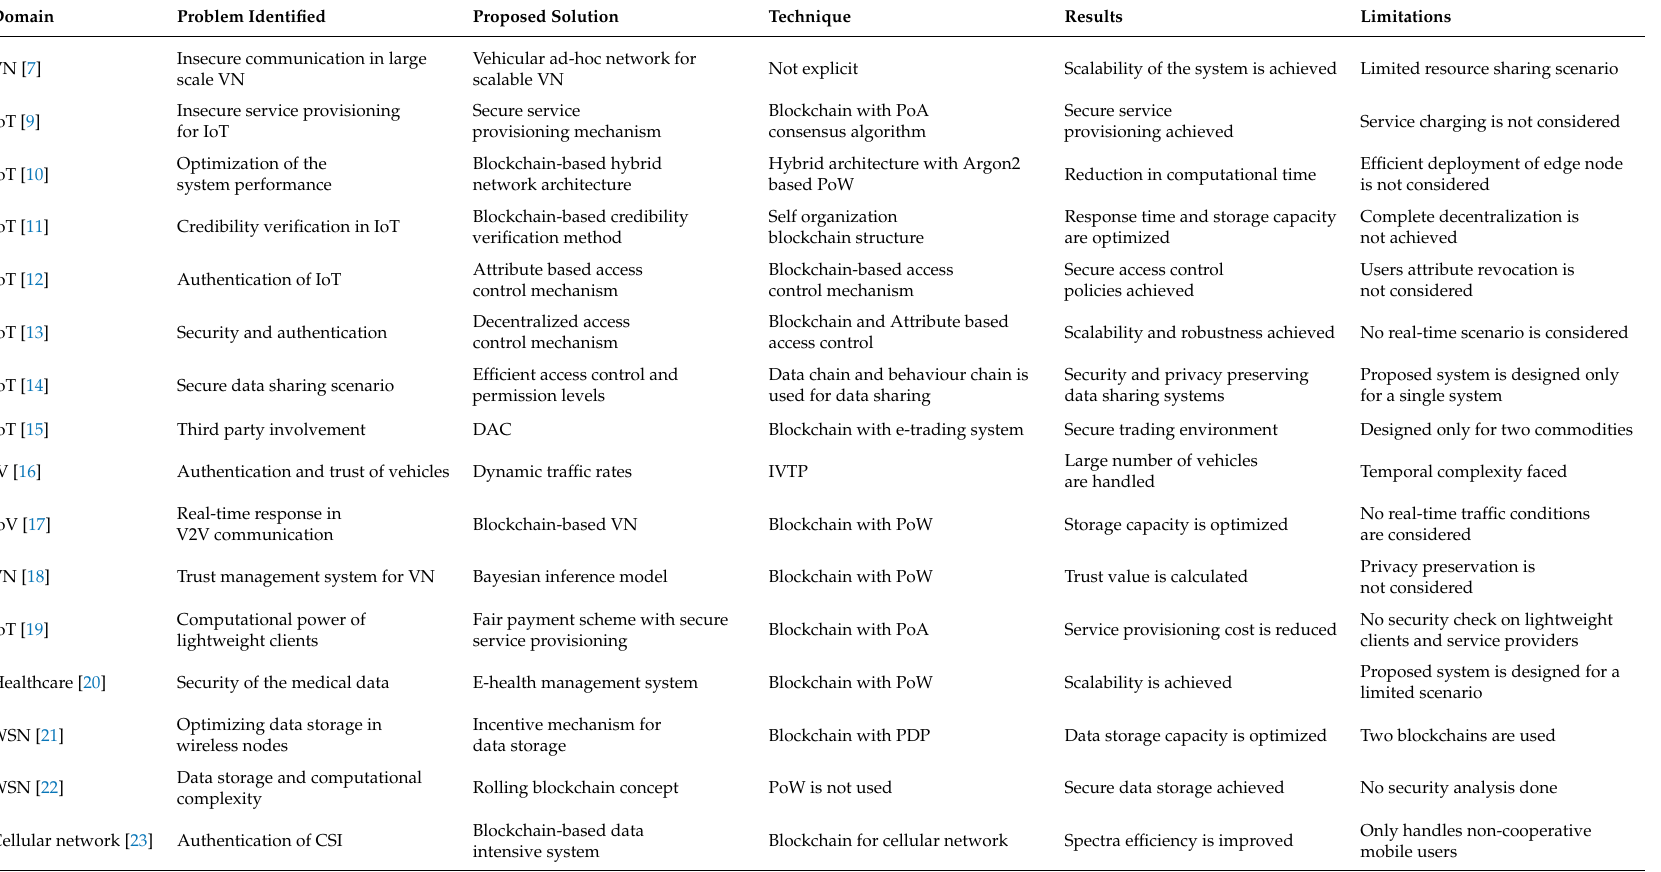
Table 1. Summarized Literature